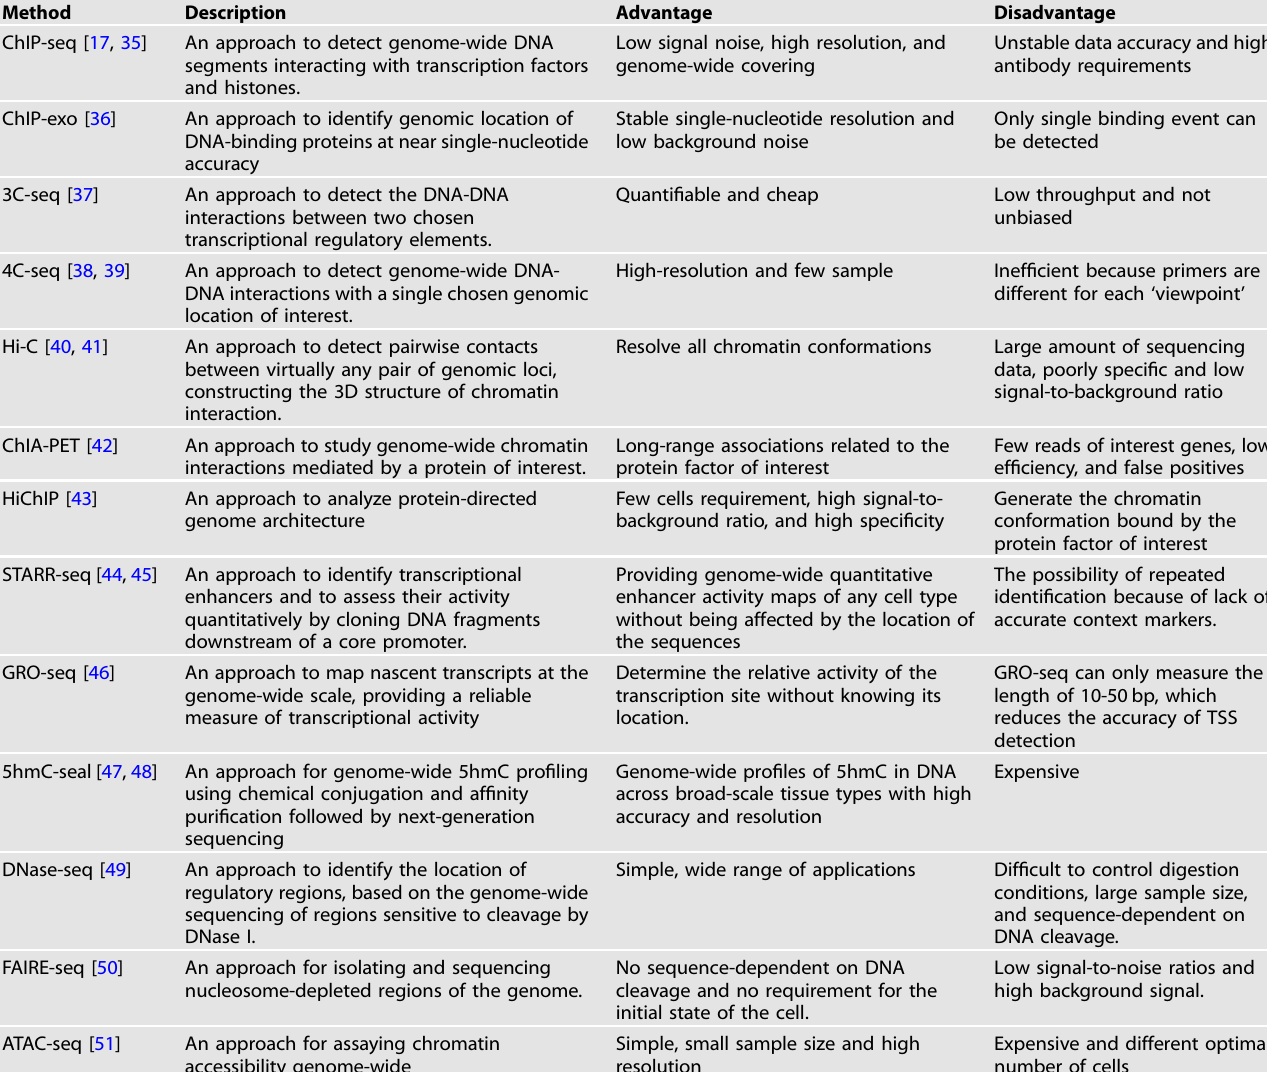
Table 1. Identi fi cation approaches of SEs in